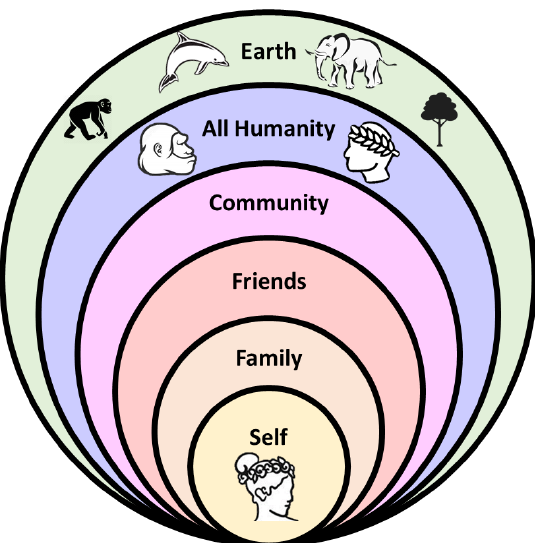
Figure 1. A 21st century adaption of Hierocles’ model of concern. It is worth stating that the “self” need not be of the Homo sapiens species and could as easily be a Neanderthal or other Homo species. One can also argue that animals, such as wolves also have a sense of self, a family (pack) and a sense of the surrounding wildlife. The circles might differ but the concept equally applies.